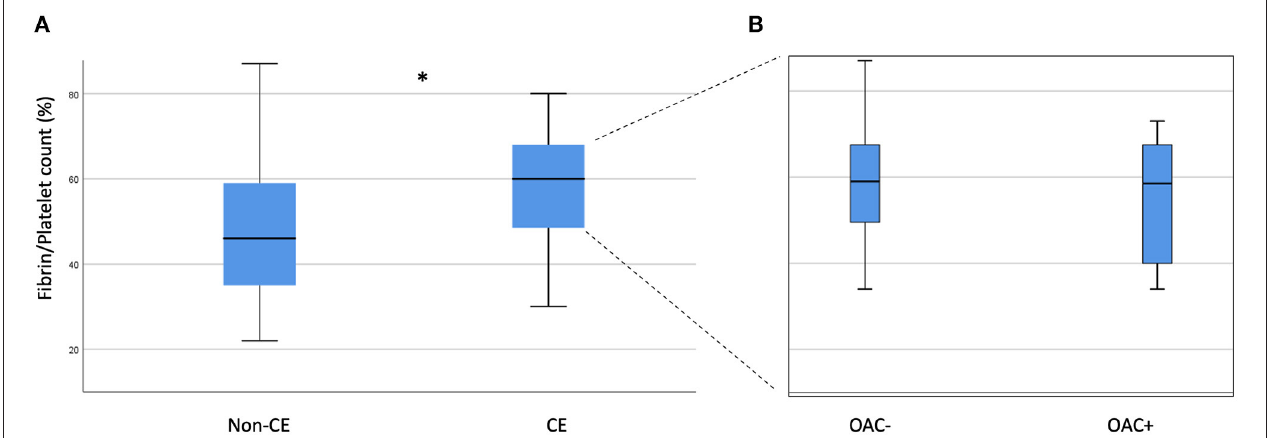
FIGURE 2 | Thrombus histology of non-cardioembolic and suspected cardioembolic thrombi with focus to prior anticoagulation. (A) Comparison of non-cardioembolic (Non-CE) and suspected cardioembolic (CE) thrombi. (B) Among cardioembolic thrombi comparison of thrombi without (OAC–) and with (OAC + ) prior anticoagulation. No statistical significant difference was observed. * indicates p <